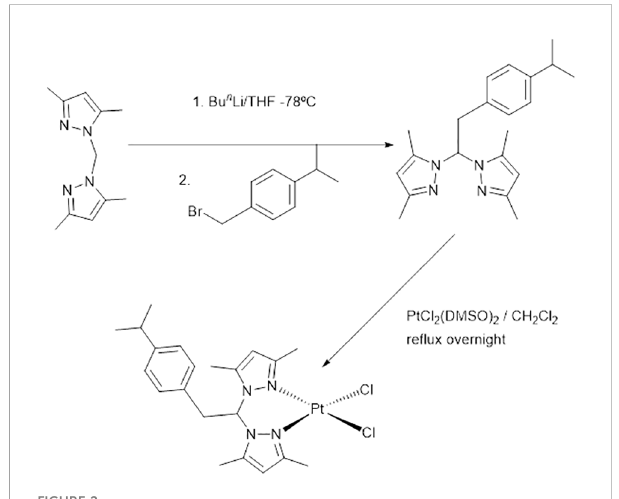
FIGURE 2 Synthesis of the platinum metallodrug